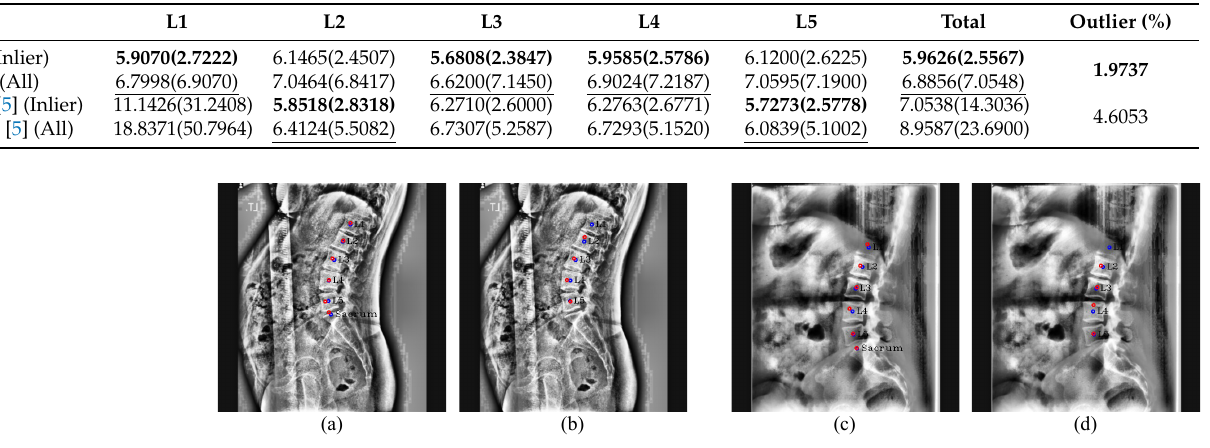
Figure 19. Results of center detection. Our results are ( a , c ), and the results of Kim et al. [5] are ( b , d ). The red circles denote the predicated centers of L1, L2, L3, L4, L5, and the sacrum in order from the top, and the blue circles and labels denote the ground truth of the center of each